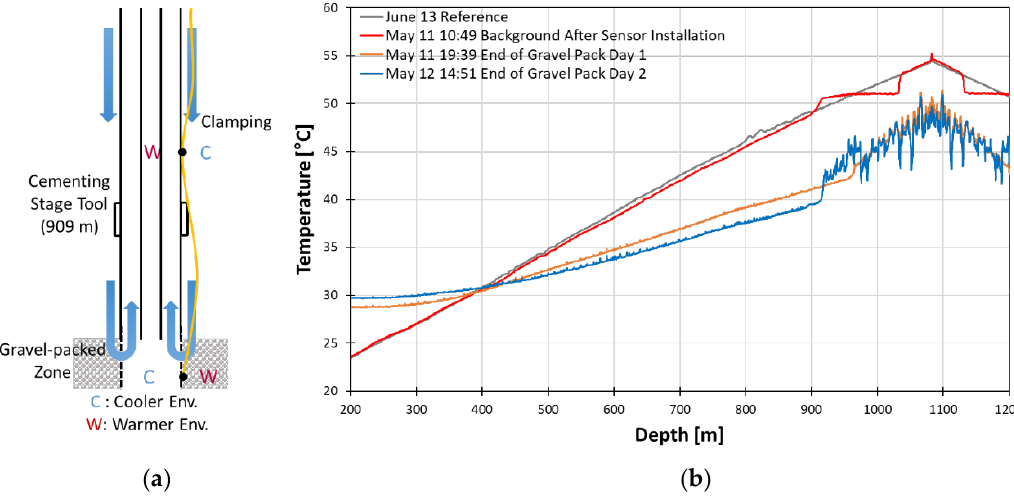
Figure 16. Schematic of gravel packing operation ( a ) and temperature profile during the gravel packing operation ( b